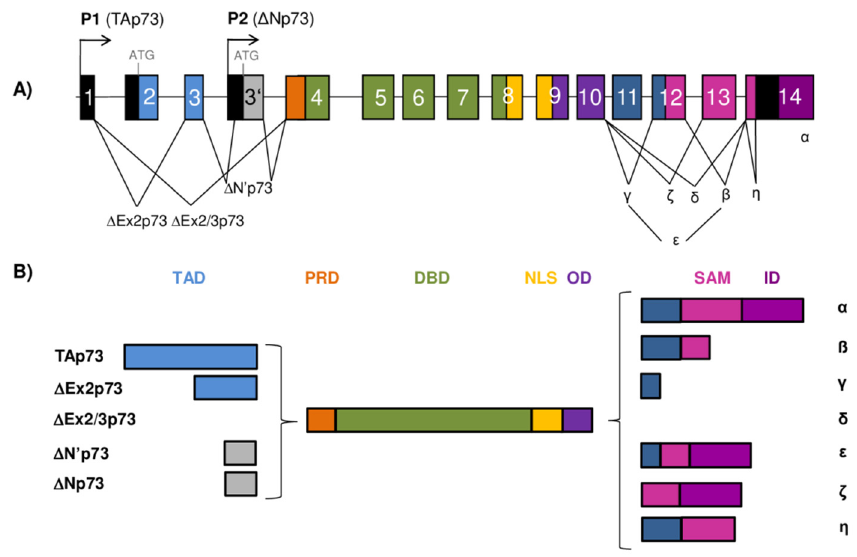
Figure 2. The TP73 gene architecture and generation of the p73 isoforms. ( A ) The scheme of the human TP73 gene structure. The human TP73 gene consists of 14 exons and additional alternative exon 3 ′ (shown as gray box). The exons are shown as boxes of different colors and noncoding sequences in black. There are two different promoters, the canonical promoter P1 upstream of exon 1 (giving rise to TAp73 isoforms) and the alternative P2 located in intron 3 (giving rise to Δ Np73 isoforms). The P1 transcript can be alternatively spliced leading to the expression of several N-terminally truncated isoforms ( Δ Ex2p73, Δ Ex2/3p73, and Δ N ′ p73). Alternative splicing is also possible at the C-terminus, giving rise to seven potential isoforms ( α , β , γ , δ , ε , ζ , and η ). ( B ) Modular structure of the p73 protein isoforms. Functional protein domains are shown in different colors matching those used for the encoding exons of the TP73 gene in ( A ). The full-length TAp73 α protein consists of a transactivation domain (TAD), a proline-rich domain (PRD), a DNA-binding domain (DBD), a nuclear-localization signal (NLS), an oligomerization domain (OD), a sterile α -motif (SAM), and an inhibitory domain (ID). There are 28 possible distinct p73 protein isoforms differing in the composition of the structural domains (as Δ ’Np73 and Δ Np73 mRNAs translate into identical proteins).